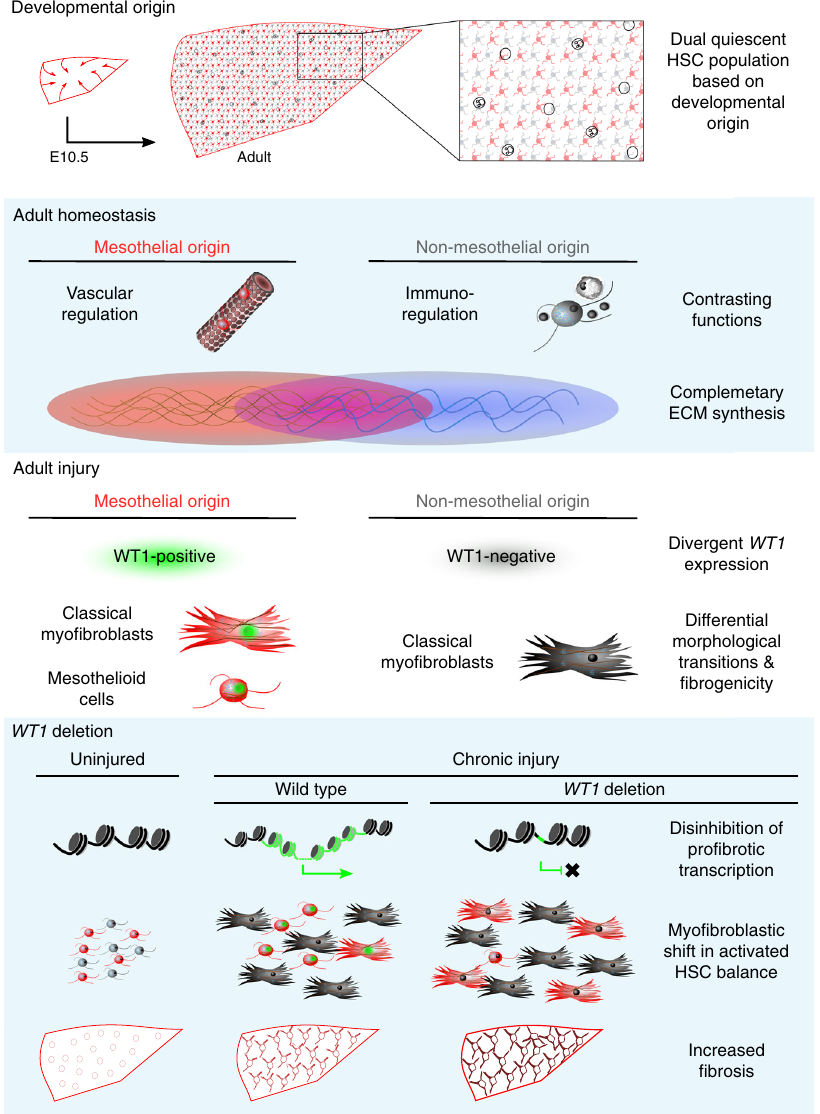
Fig. 10 WT1 is a paradoxical negative regulator of fi brogenesis in distinct subpopulations of aHSCs de fi ned by WT1 expression. WT1-positive subpopulations in liver injury are generated by activation of speci fi c progenitors that derive from the embryonic hepatic mesothelium in early development. Developmental origin determines the functional categorisation of qHSCs; those derived from the mesothelium demonstrate engagement of vascular regulatory pathways, whilst those from non-mesothelial sources have immunomodulatory transcriptional pro fi